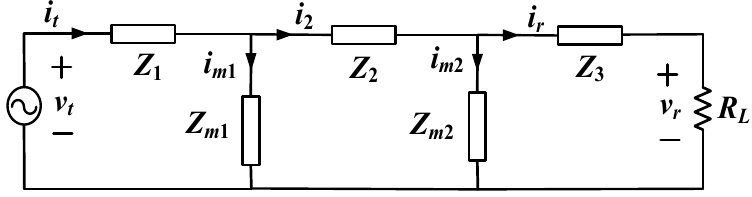
Figure 3. Fundamental schematic diagram of a three-coil WPT system.